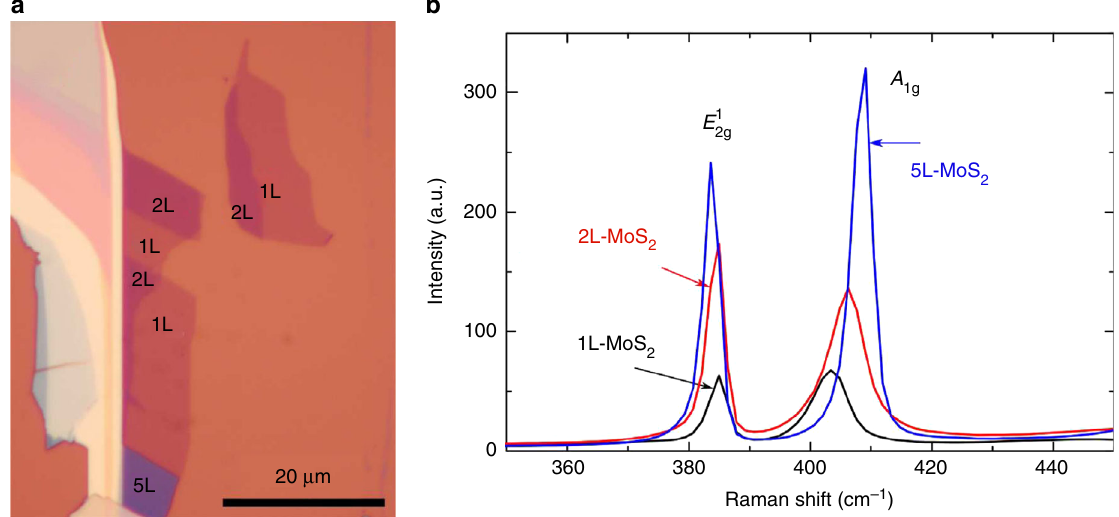
Fig. 1 Optical image and Raman spectra of the MoS 2 fl akes. a Optical micrograph with single-layer, bilayer, and fi ve-layer areas marked by 1L, 2L, and 5L. b Raman spectra of the same